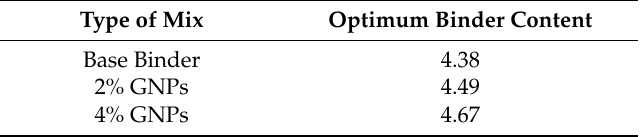
Table 3. The Optimum Binder Content (OBC) of the asphalt mixtures.